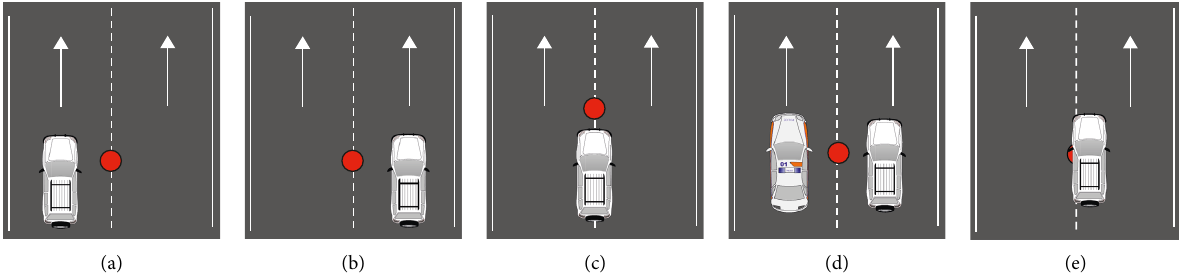
Figure 7: Schematic diagram of five detection scenarios. (a) Scenario 1. (b) Scenario 2. (c) Scenario 3. (d) Scenario 4. (e) Scenario